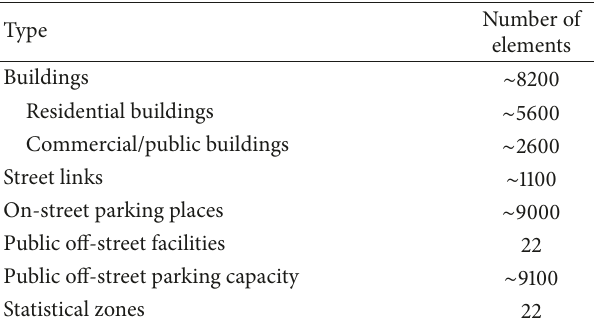
Table 1: Characteristics of the study